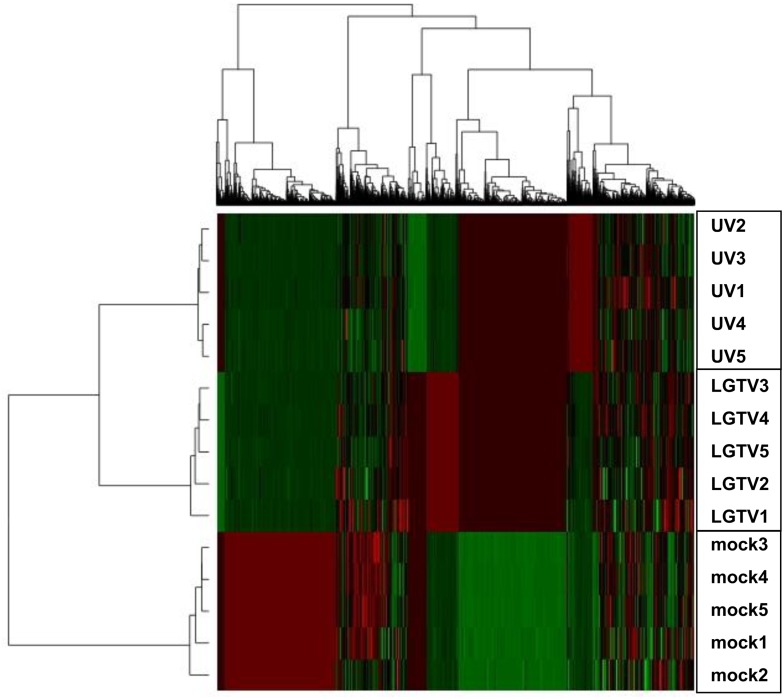
Hierarchical clustering of MS peak profiles of ISE6 cells treated with LGTV, UV-LGTV, and mock.M1-5, mock1-5 samples; LGTV1-5, LGTV-infected samples 1–5, and UV-LGTV1-5, UV-LGTV samples 1–5. Vertical rows depict n = 5 biological replicates. Horizontal rows correspond to significant MS peaks of peptides/proteins at 36 hours post infection/treatment. Clustering analysis shows common patterns of protein expression profiles shared between the three treatment groups. The red-green color scale denotes the Z score fold change with red representing a Z score of -2 and green denoting a Z score of 2 [41].